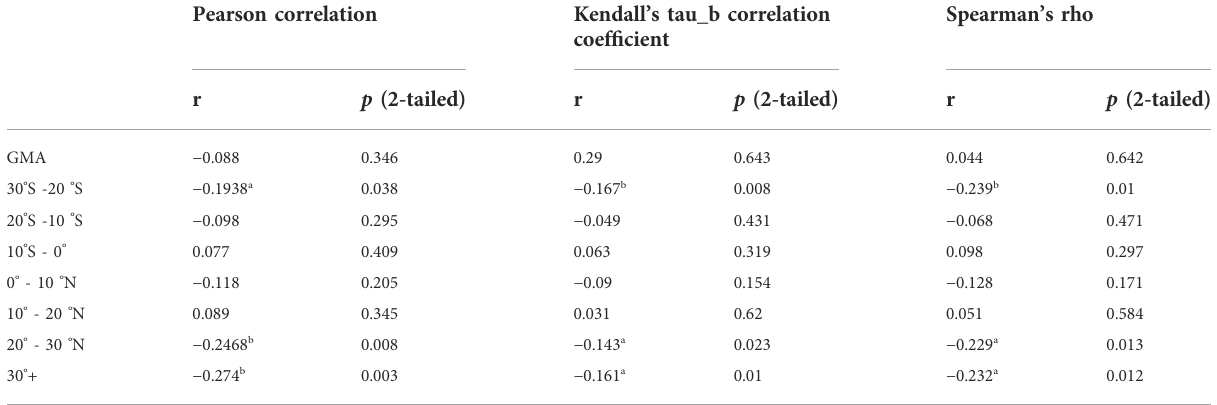
TABLE 5 the correlation coef fi cient between reconstructions and instrumental